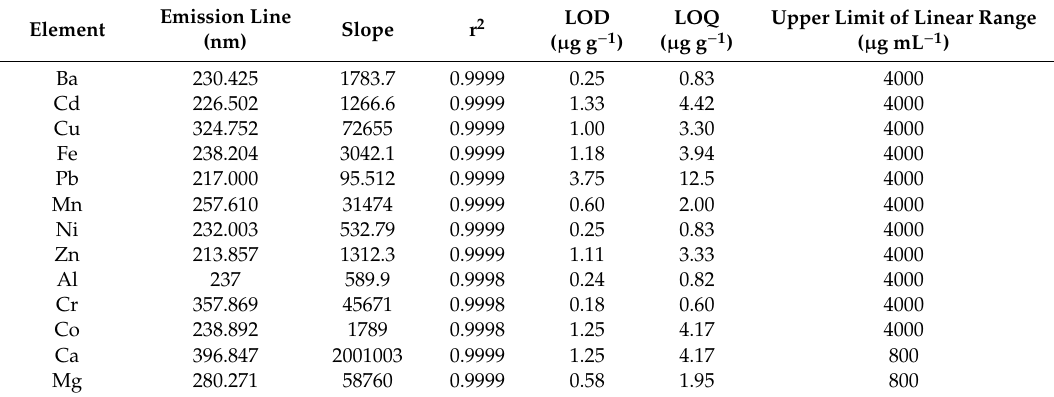
Table 3. Calibration curves, linear range, limits of detection (LODs) and limits of quantification (LOQs) of the developed inductively coupled plasma atomic emission spectroscopy (ICP-AES)